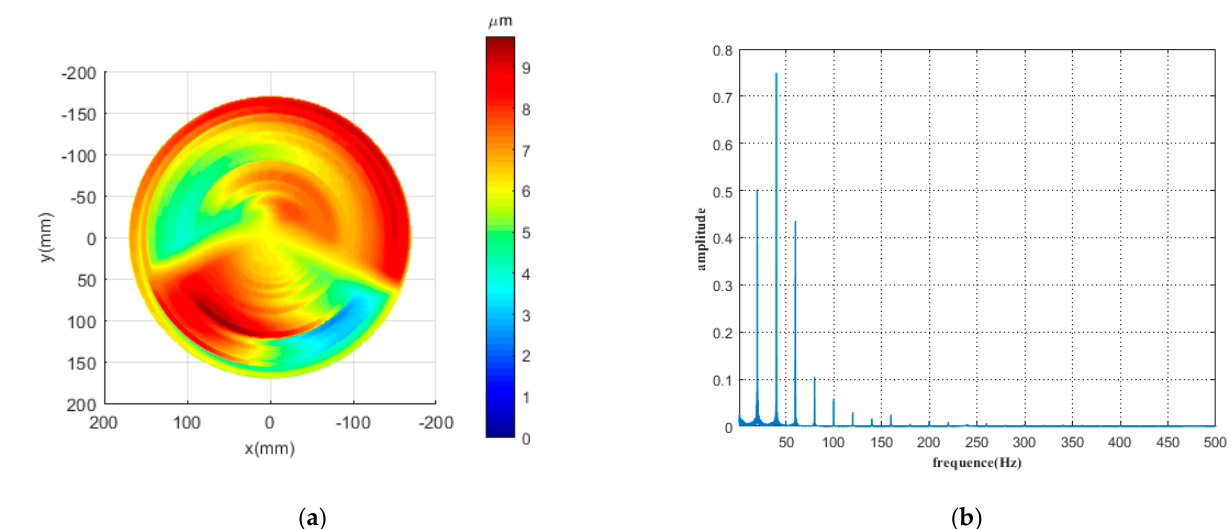
Figure 1. ( a ) A typical error profile; ( b ) spectrogram of machining trajectory.